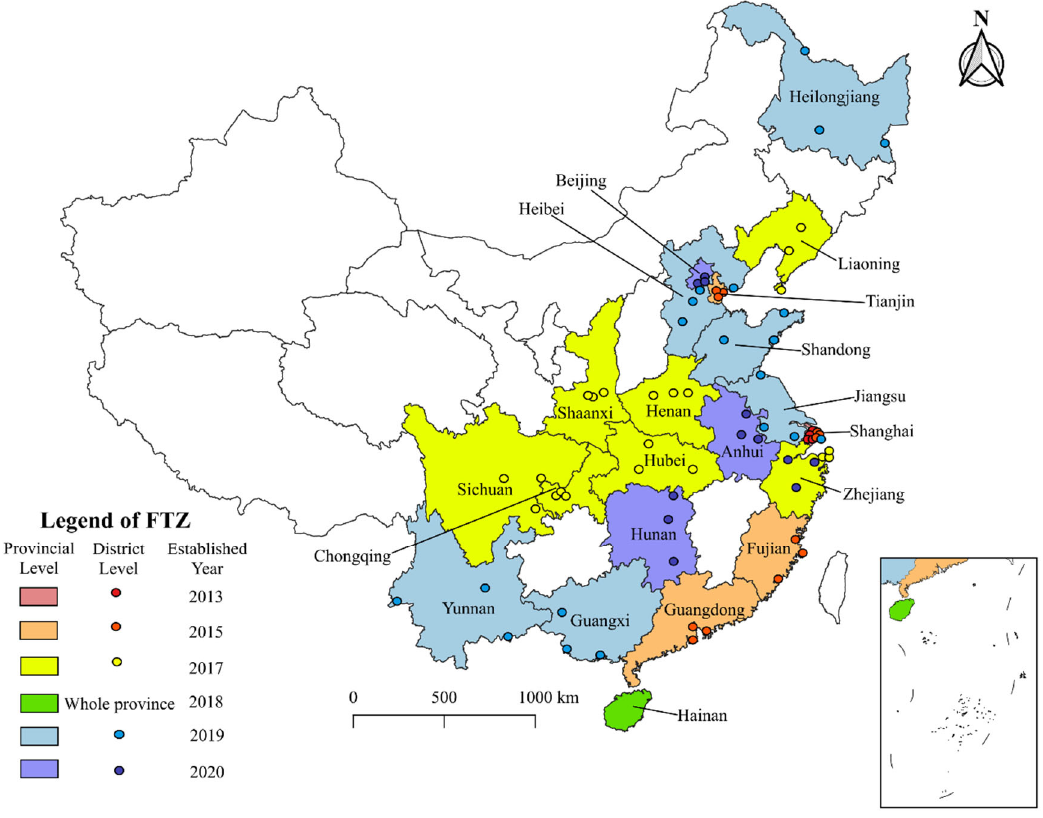
Figure 1. The FTZ distributions in mainland China (up to June 2022).